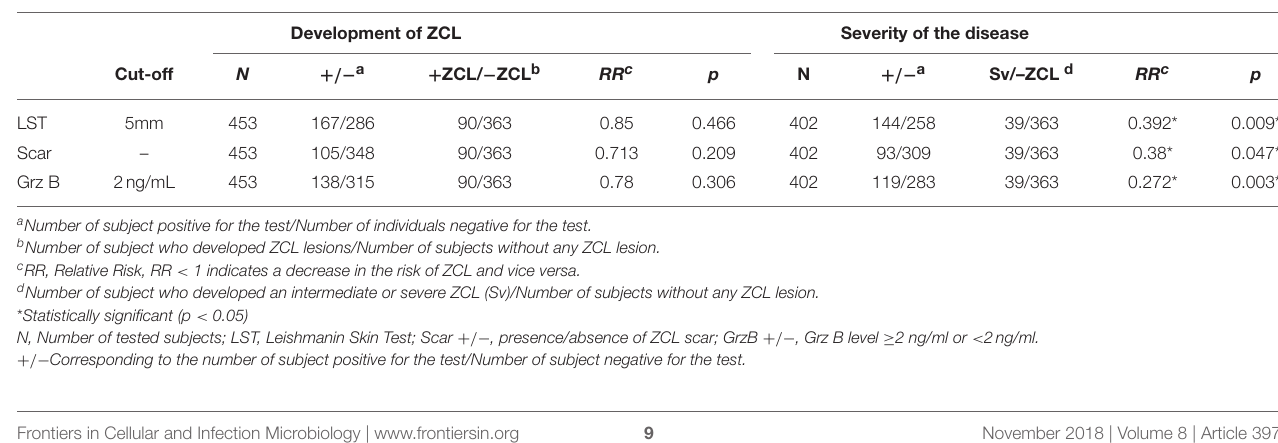
TABLE 4 | The relative risk ( RR ) of the different